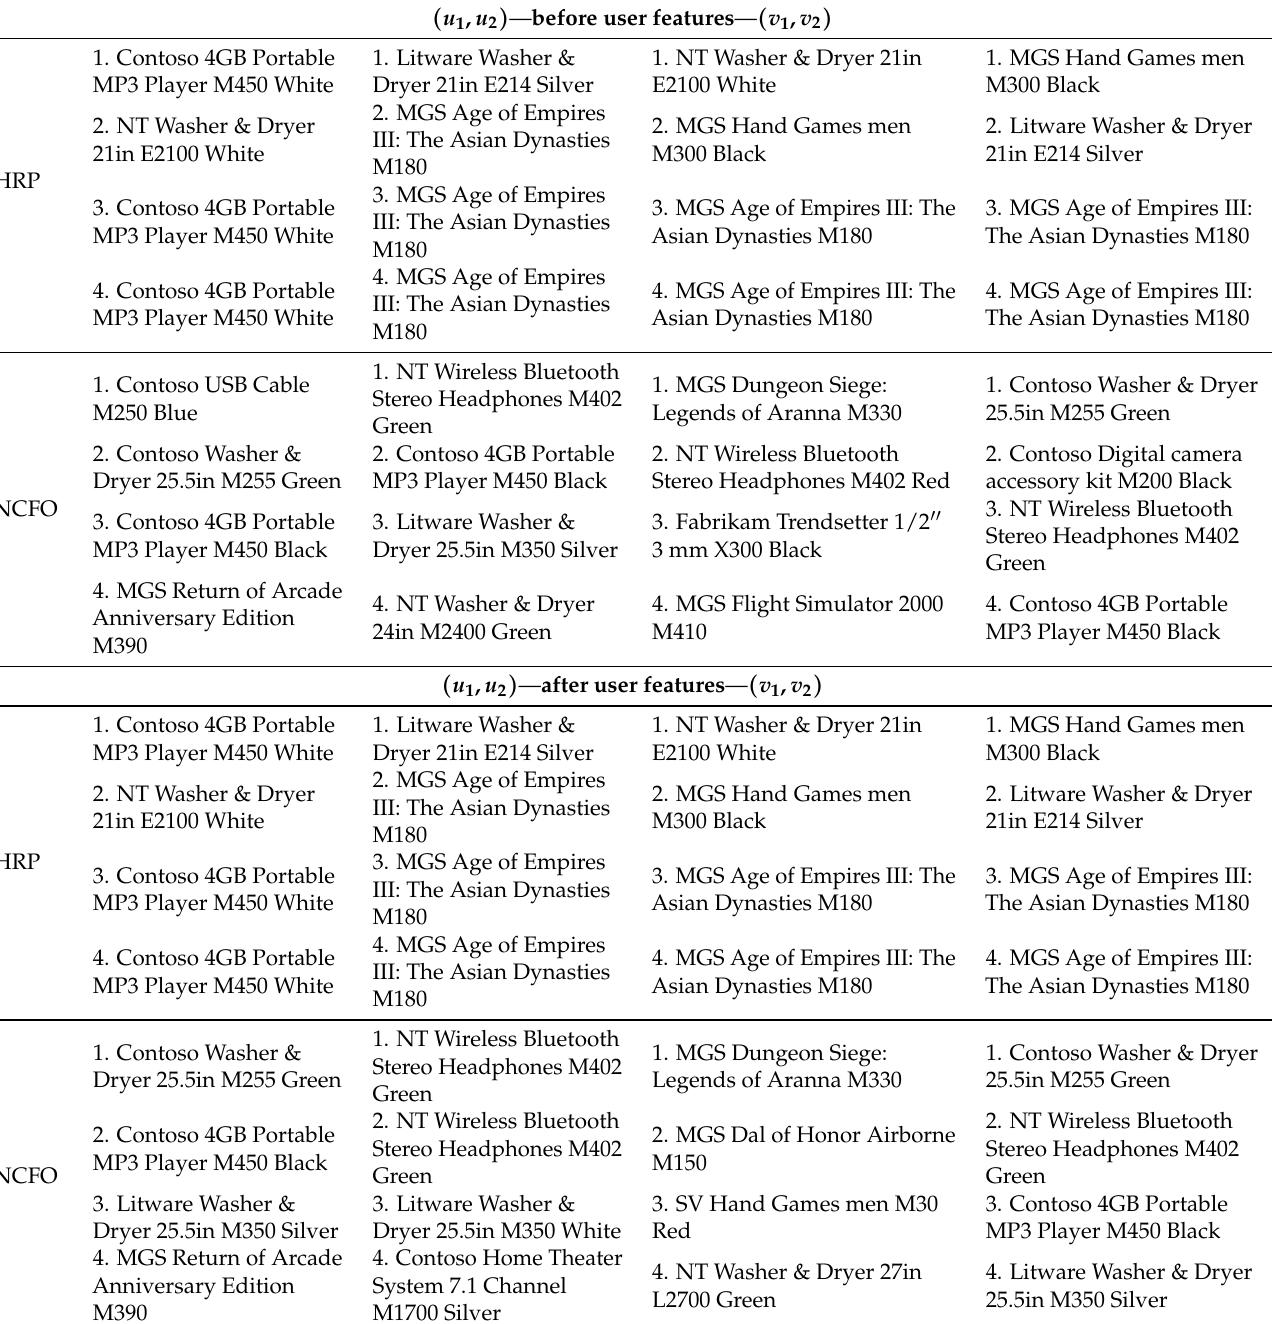
Table 9. Top-four recommendations (NCFO) and highly rated products for two pairs of aligned users. Original